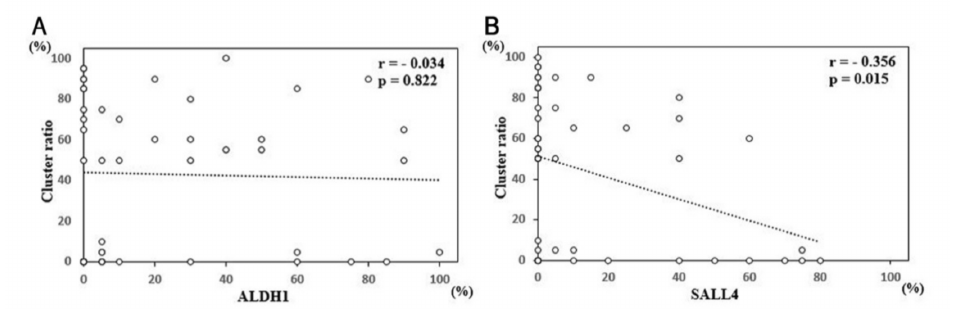
Figure 4. Sal-like 4 (SALL4) expression is inversely associated with cluster formation. ( A , B ) Correla- tion of aldehyde dehydrogenase 1 (ALDH1) ( A ) and SALL4 expression ( B ) with the cluster ratio in patients with malignant pleural effusion.